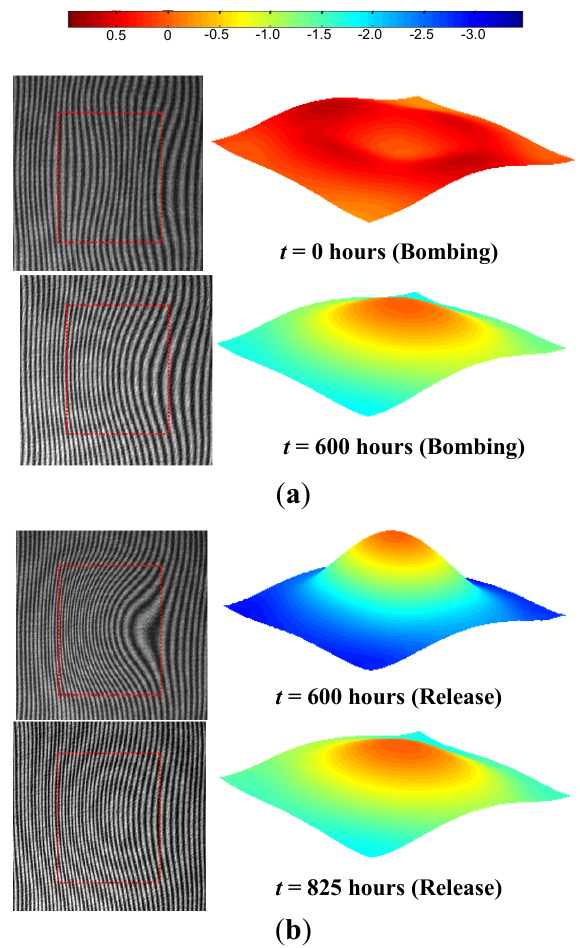
Figure 12. Cap surface topographical contour maps (the units in the scale are μ m and the cavity location is indicated by the dotted box) at the beginning and the end of ( a ) bombing stage and ( b ) release stage.